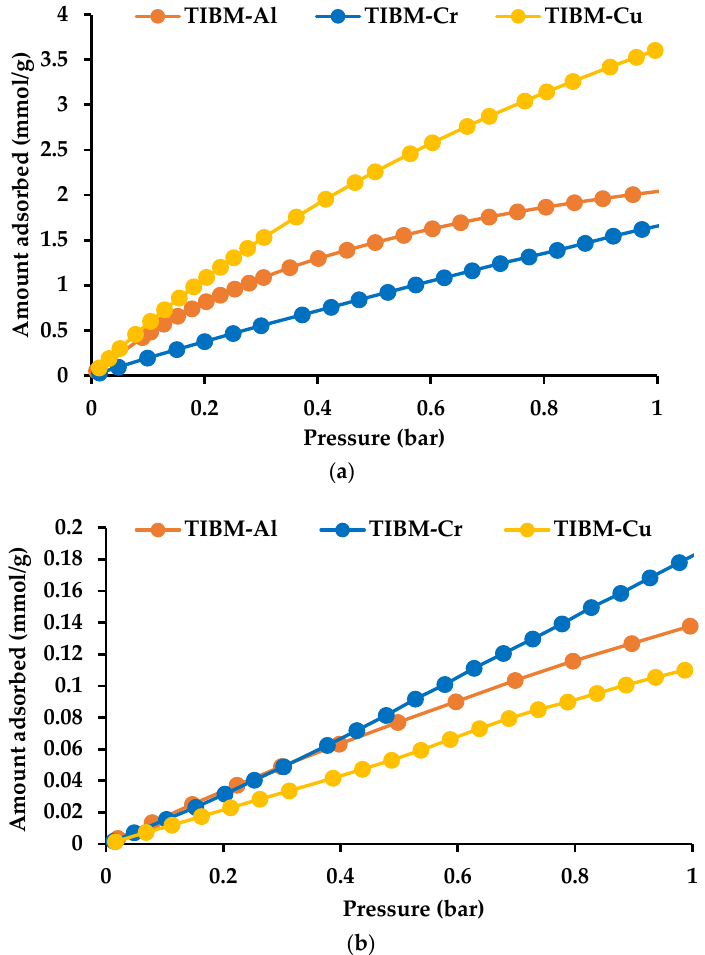
Figure 6. ( a ) CO 2 and ( b ) N 2 adsorption capacities at 298 K for TIBM-Al, TIBM-Cr, and TIBM-Cu MOFs. Table 3. CO 2 adsorption capacities of different MOFs.